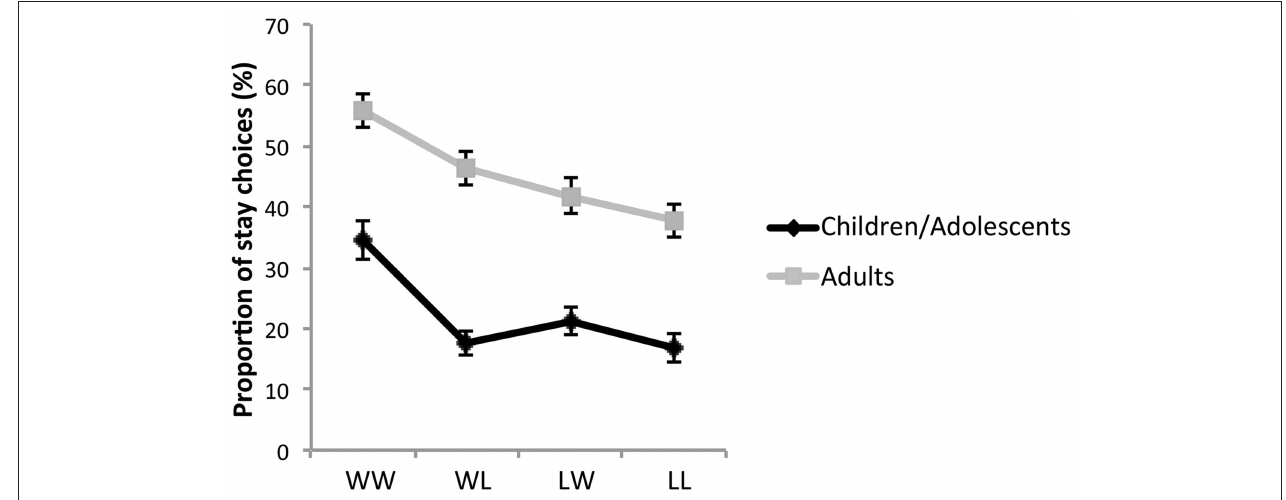
FIGURE 3 | The proportion of choices where the same deck was chosen from previous trial (i.e., proportion of stay choices) across four different outcome scenarios of self and charity in children/adolescents and adults. WW refers to the case in which there were positive outcomes for both self and charity, WL refers to a positive outcome for self and a negative outcome for charity, LW refers to a negative outcome for self and a positive outcome for charity and LL refers to negative outcomes for both self and charity. Error bars indicate standard error.